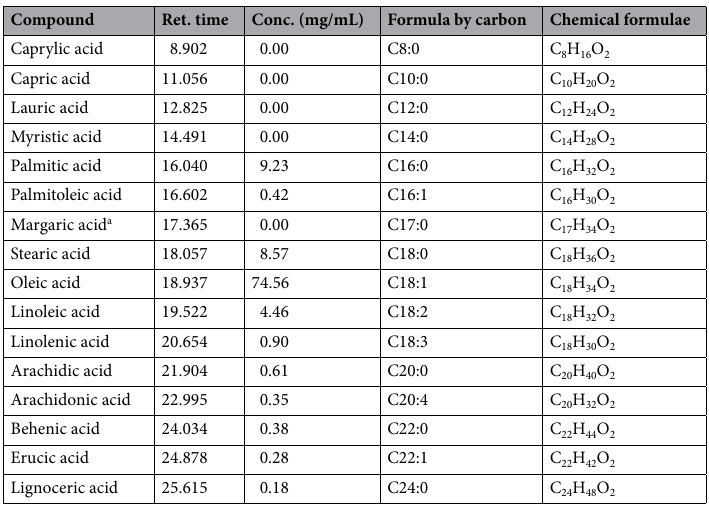
Table 3. Fatty acid profile of C. schweinfurthii pulp oil, based on compounds, retention time, concentration, carbon chain ratio, and chemical formulae. a Margaric acid methyl ester (C17:0) served as an internal standard.